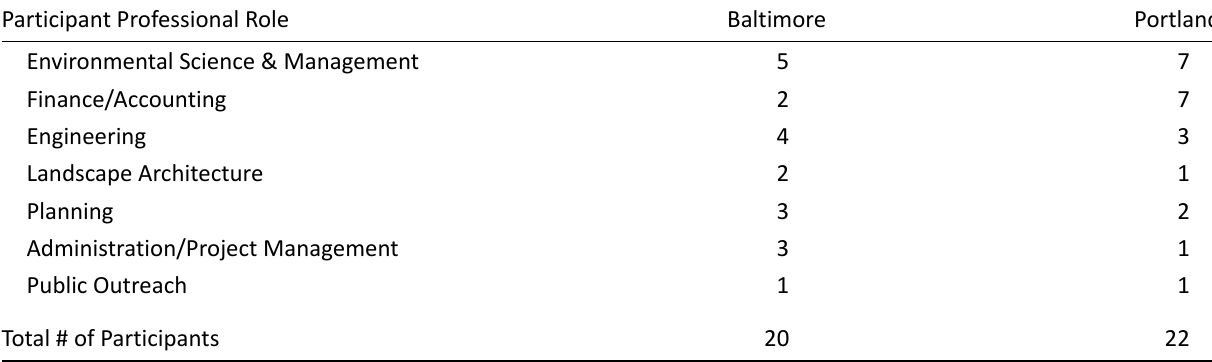
Table 2. Breakdown of interviewees by city and professional